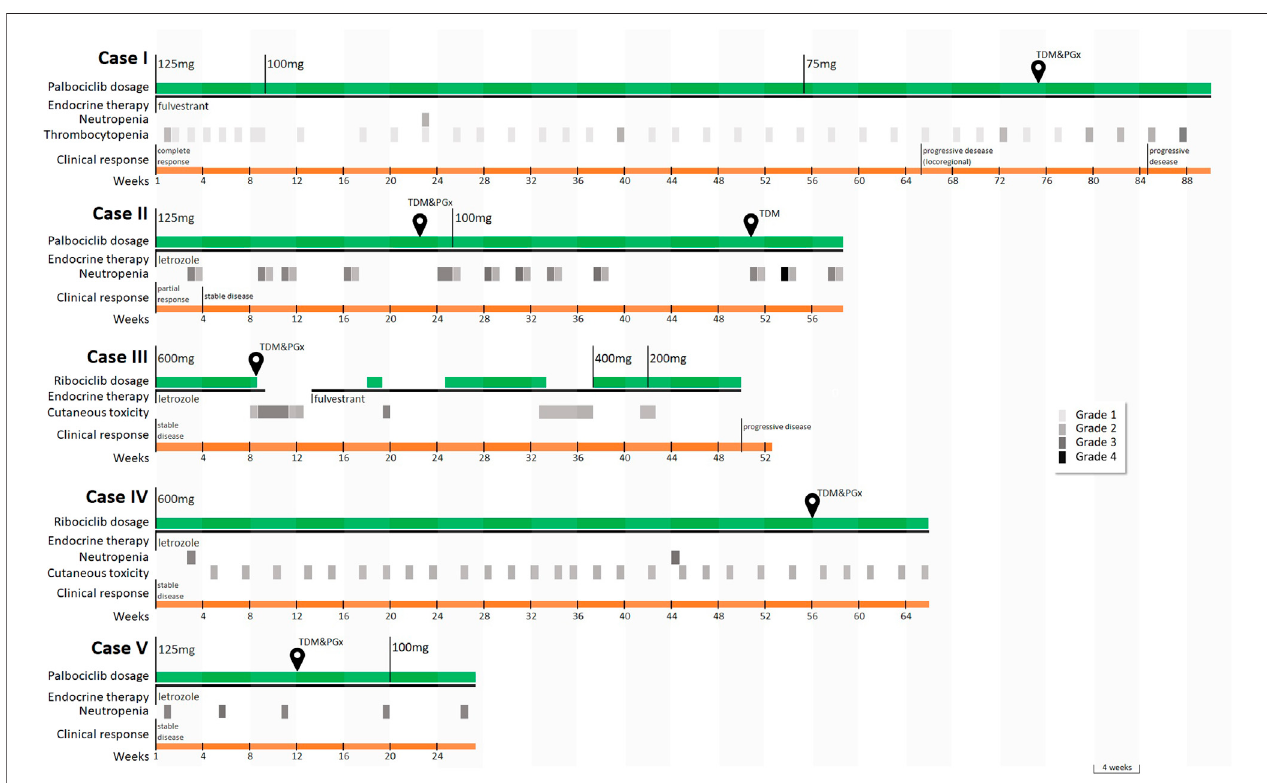
FIGURE 2 | Timeline of the main events and sample collection for case series ’ patients. Temporary postponements of therapy scheduled by the drug data sheet upontheoccurrenceoftoxicityarenotdisplayed.Legend:CR,completeresponse;PD,progressivedisease;PR,partialresponse;SD,stabledisease;TDM,therapeutic drug monitoring; PGx, pharmacogenetic analysis. Toxicities were graded according to Common Terminology Criteria for Adverse Events (CTCAE) Version 5.0.